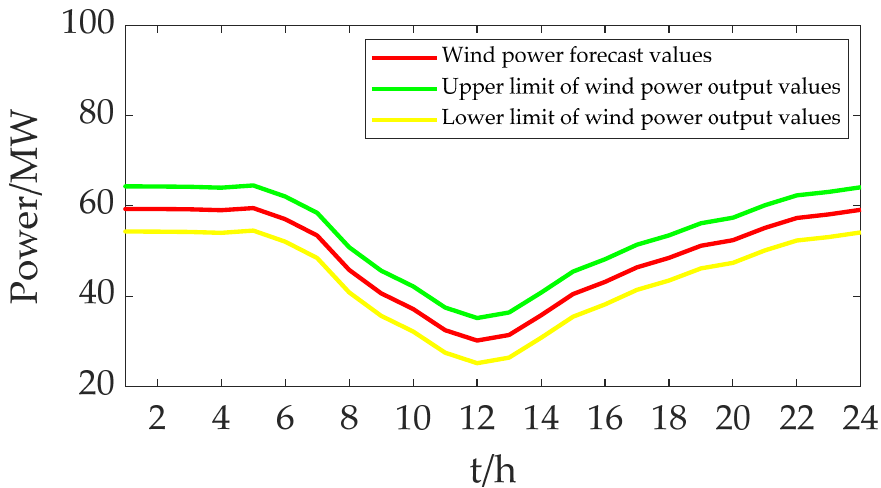
Figure 10. Wind power forecast values and upper and lower limits of wind output power values.